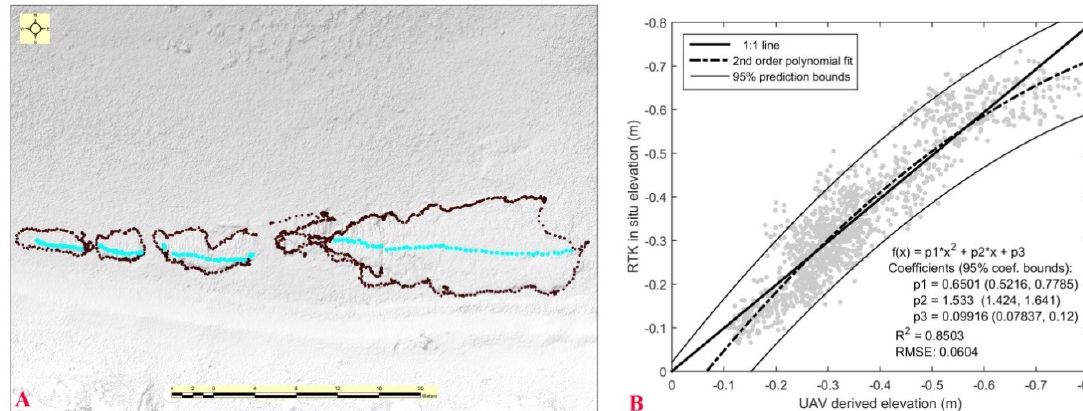
Figure 8. ( A ). GNSS measurements took place around (purple color points) and on the top of the beachrock (cyan color points). ( B ). Comparison between the GNSS and photogrammetry-derived DSM. The 1:1 line corresponds to the linear regression used for the DSM calibration, while a further 2nd order polynomial provided the best possible fit with the data (R 2 ~ 0.85 and root mean squared